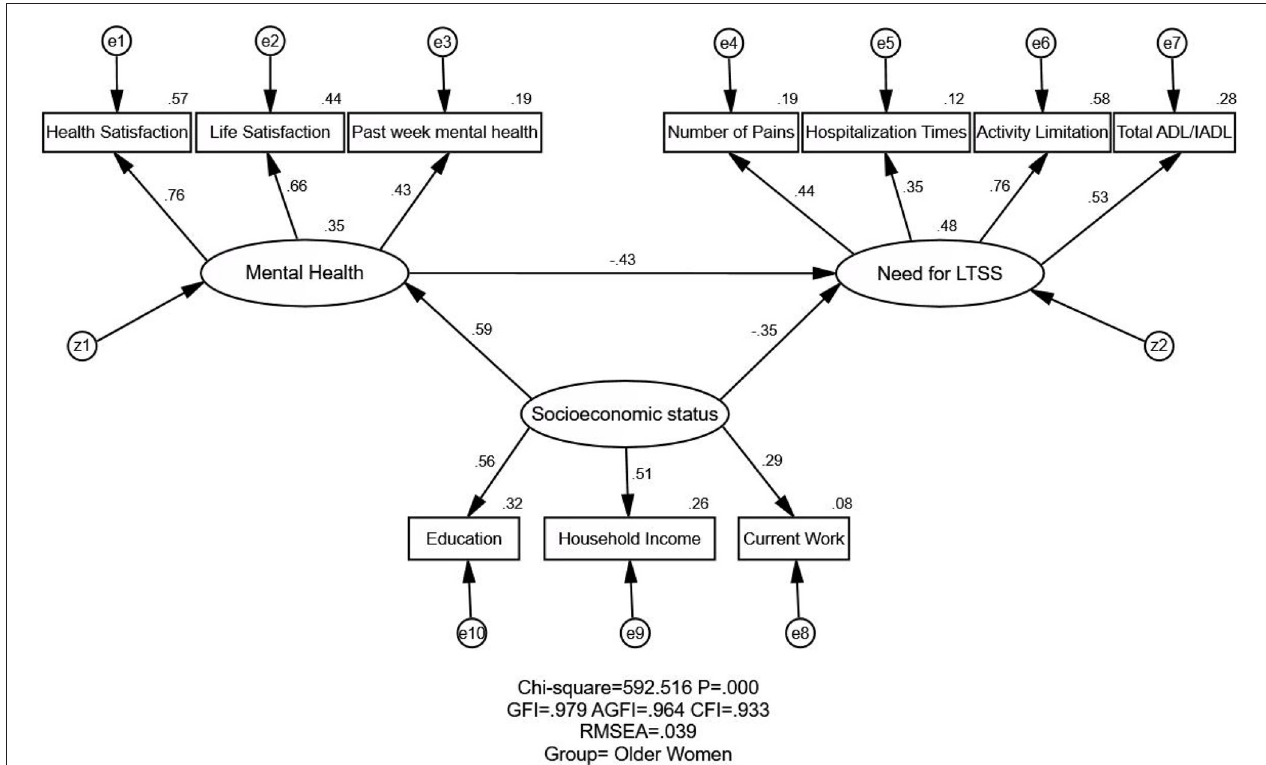
FIGURE 2 | Structural equation modeling analysis of the association between SES, mental health, and the need for LTSS among South Korea’s older women ( n = 3,174). The data were employed to analyze the association between SES, mental health, and the need for LTSS. The arrows indicate the associations and directions between variables. All parameter estimates were statistically significant ( p < 0.001). χ 2 , chi-square value; GFI, goodness of fit index; AGFI, adjusted goodness of fit index; RMSEA, root-mean-square error of approximation; SES, socioeconomic status; Need for LTSS, need for long-term services and support; CMIN, the chi-square value as noted in